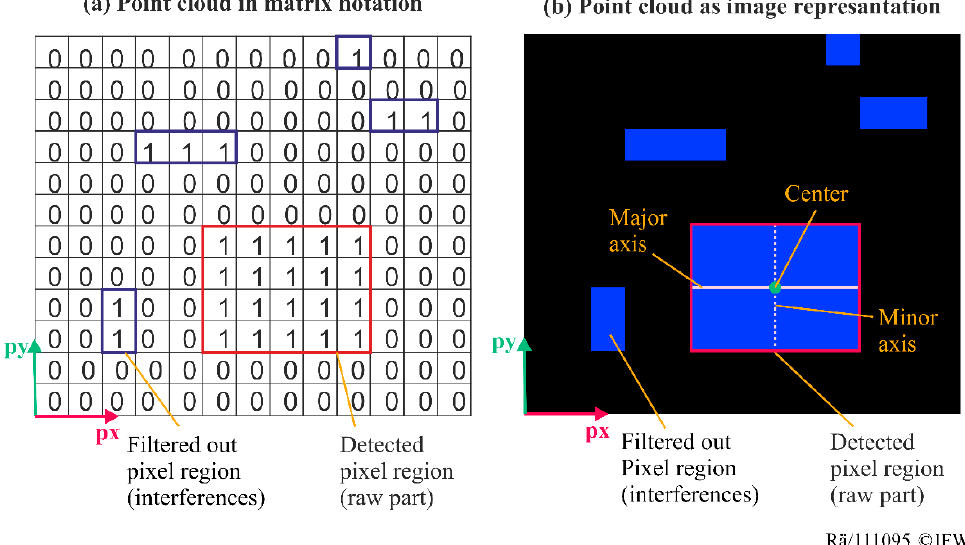
Figure 9. ( a , b ) Logic beyond the bounding-box algorithm.